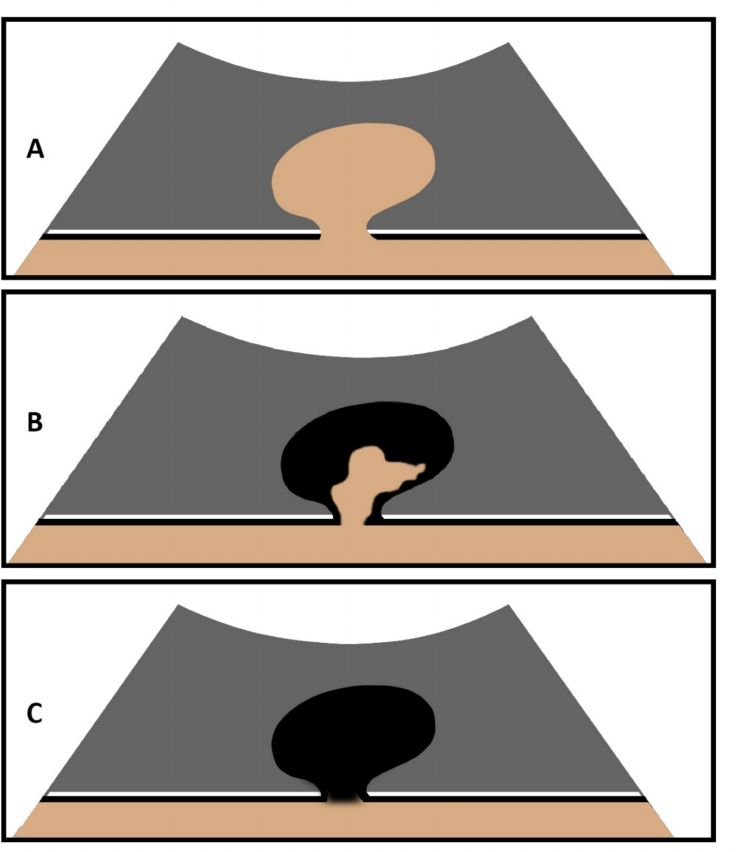
Figure 1. Graphical illustration of an abdominal wall hernia on CEUS with marked contrast enhance- ment of hernia content ( A ), partial absent enhancement of hernia content ( B ), and complete absent enhancement of hernia content ( C